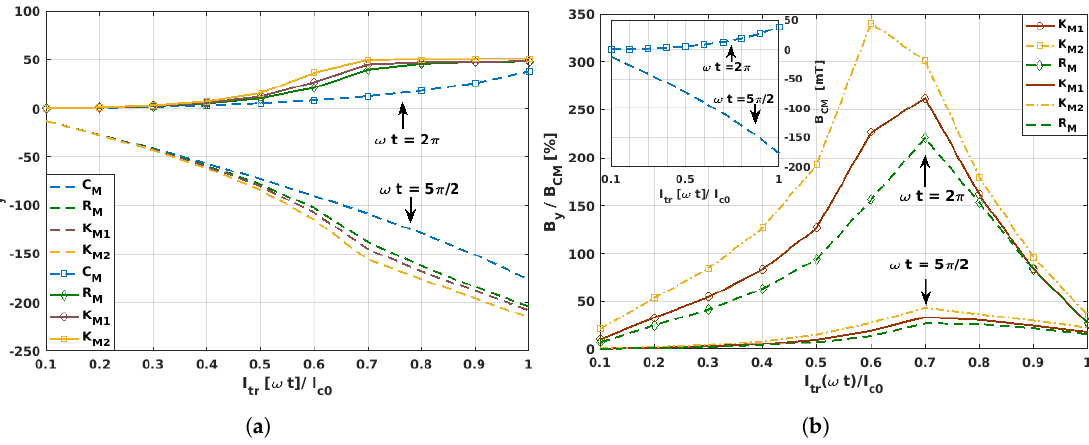
Figure 4. ( a ) Magnetic field component B y at the middle point of the external surface of the innermost turn of the 2G-HTS coil as a function of the applied transport current I tr [ ω t ] at the self-field ( ω t = 2 π ) and peak transport current ( ω t = 5 π /2 ) conditions, and the different material laws presented in Table 1. ( b ) The relative percent ratio between the different material laws, taking as a reference the B y -field obtained within the critical-state-like-model C M (inset).